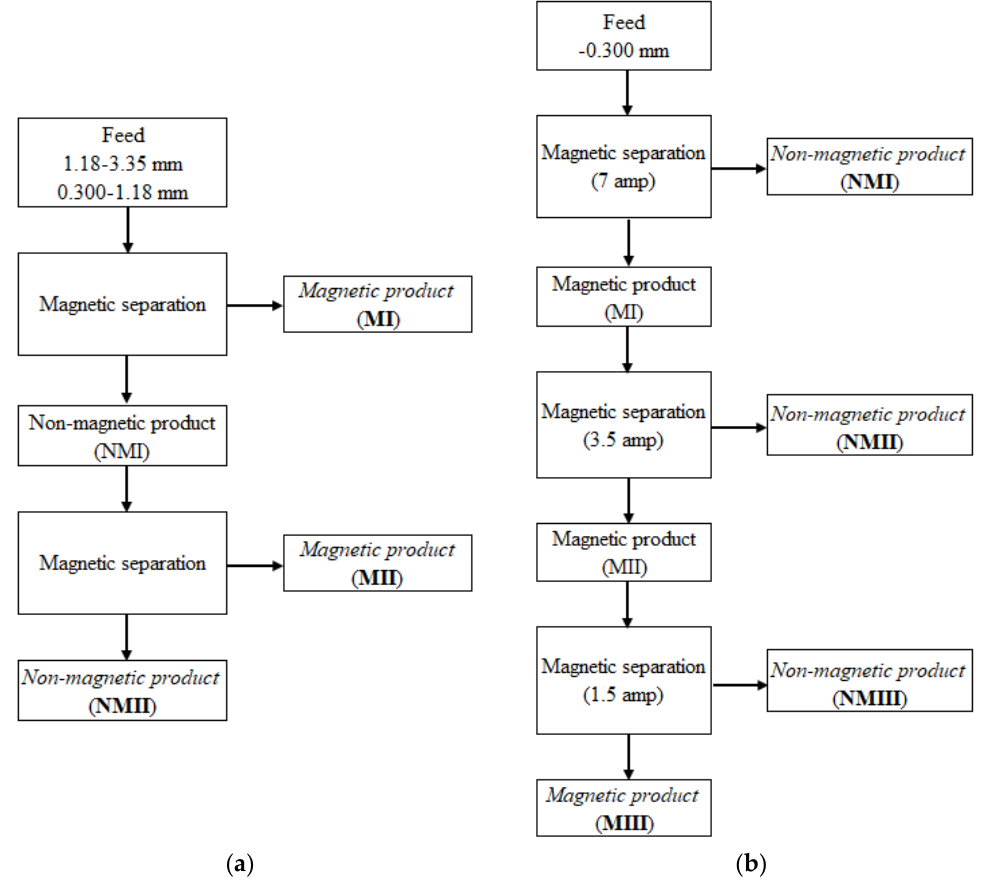
Figure 1. Schematic diagram of the process for the magnetic separation of ( a ) coarse fractions (1.18 – 3.35 mm and 0.300 – 1.18 mm) and ( b ) fine fraction (−0.300 mm)